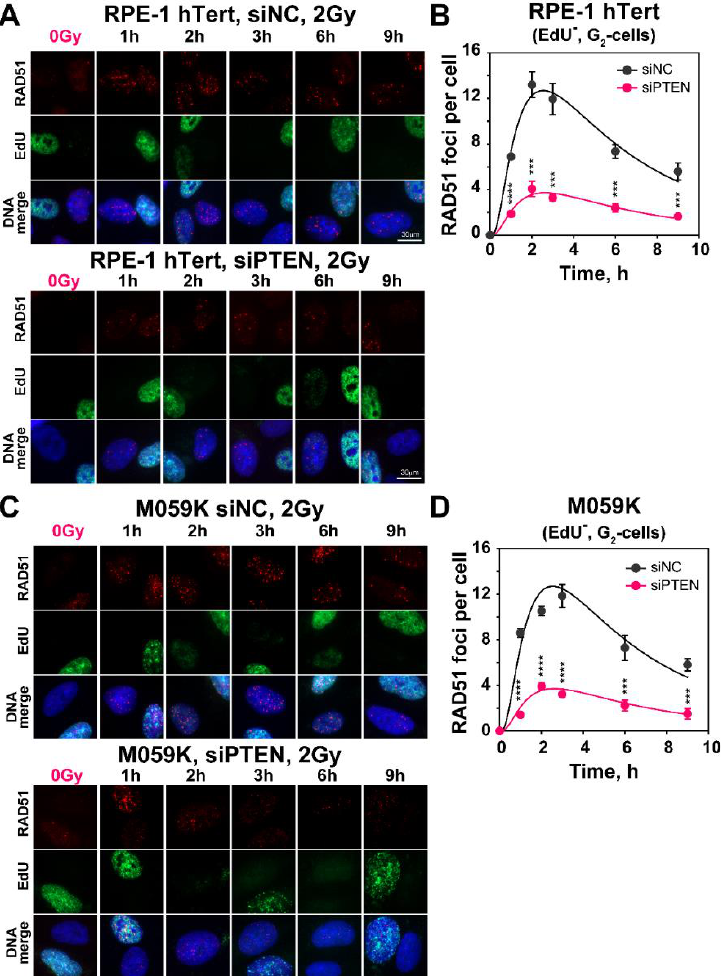
Figure 3. PTEN deficiency results in decreased number of IR-induced RAD51 repair foci. ( A ) Representative images of RAD51 foci in RPE-1 hTert cells, irradiated with 2 Gy of X-rays and collected at the indicated times after irradiation. Forty-eight hours before irradiation, cells were transfected with siNC or siPTEN, siRNA. ( B ) Quantification of RAD51 foci in siNC and siPTEN, RPE-1 hTert, EdU − , G 2 -cells. ( C ) Same as panel ( A ), but for M059K cells. ( D ) Same as panel ( B ), but for M059K cells. Cell cycle-specific RAD51 foci analysis was performed in EdU negative, G 2 -phase cells (EdU-, G 2 -cells), as described in Materials and Methods. The scale bar is 30 µ m for all images. Data represent the mean and ± SD from three independent determinations. The significance level, or p -value, is calculated using the two-tailed Student ´ s t -test: ns (not significant), * p < 0.05, ** p < 0.01, *** p < 0.001, **** p <